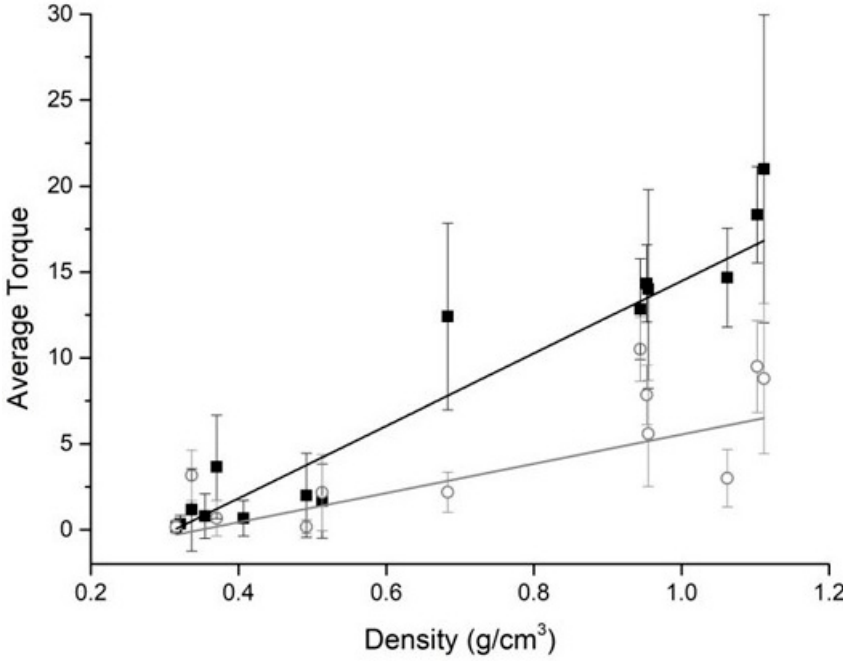
Figure 3. Plots of the mean torque (N × cm) measured by the instrument and the actual density of the bone blocks. Graphs obtained plotting average torque values collected without irrigation (black squares) and with irrigation (gray circles) are shown.